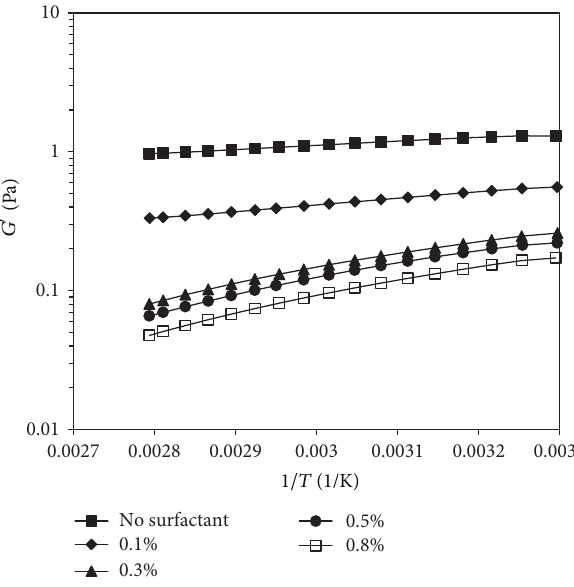
Figure 9: Effect of temperature on G 󸀠 of 0.25% copolymer at different surfactant